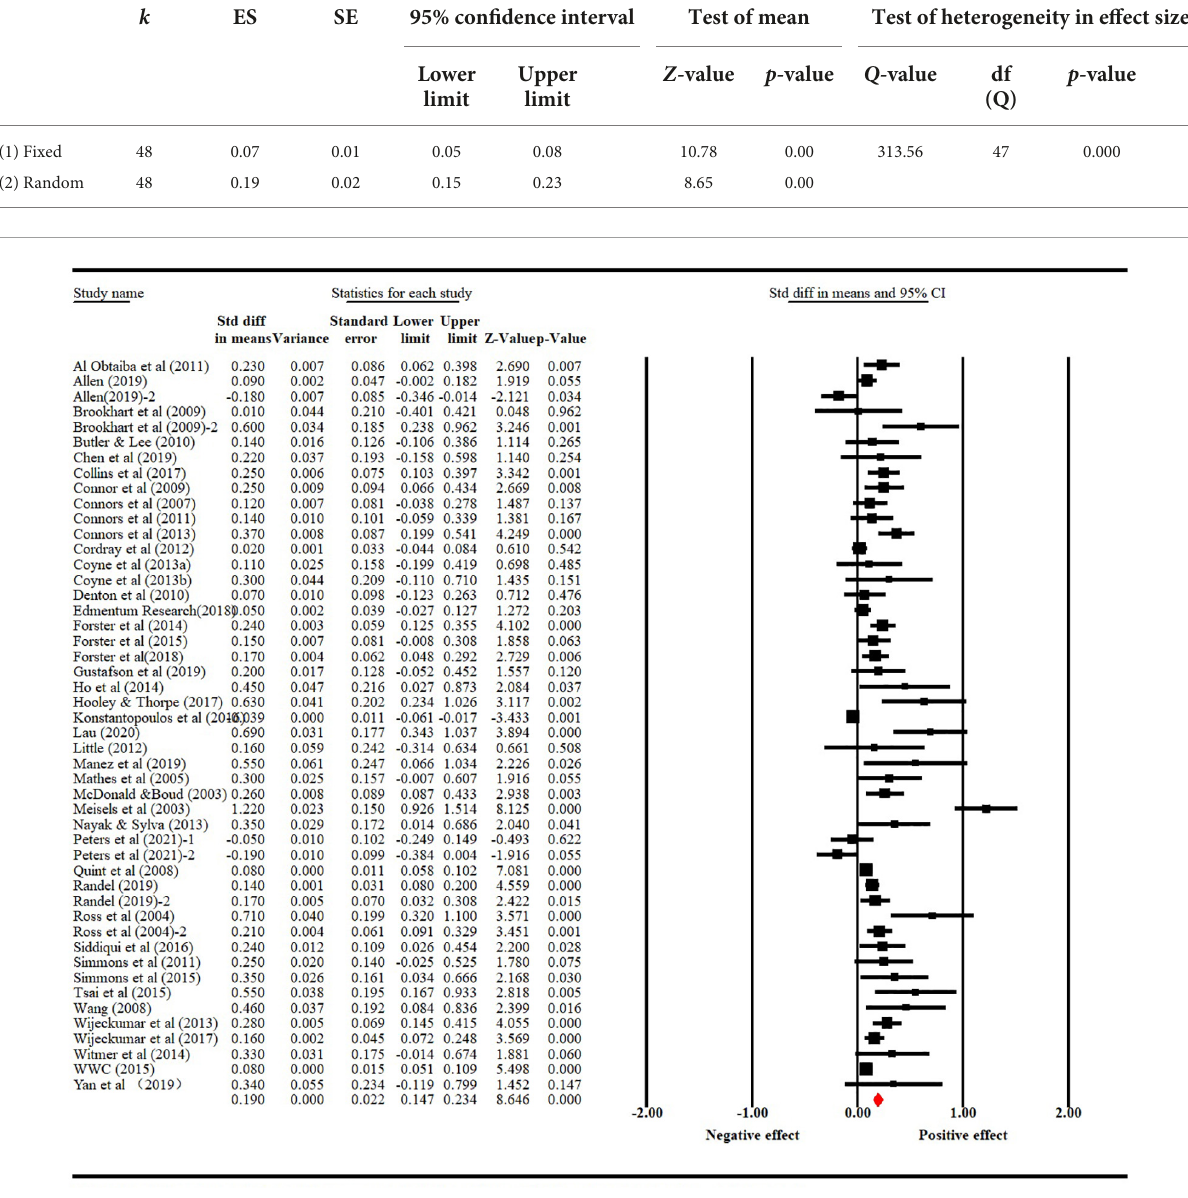
TABLE 3 Overall effect size.